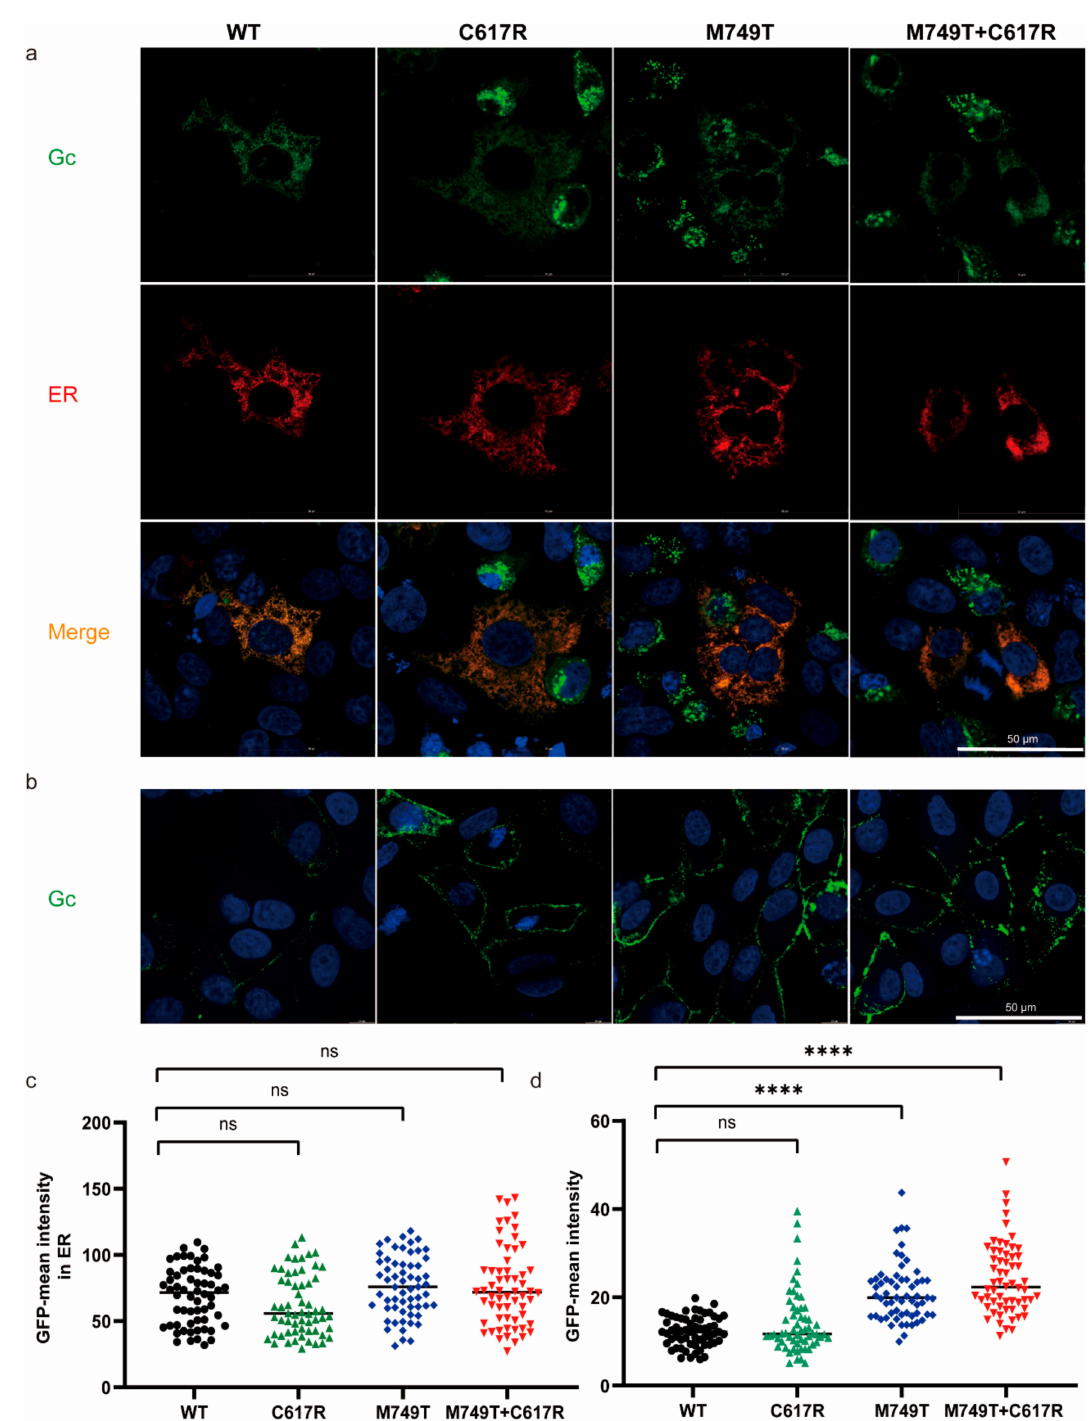
Figure 2. The effect of M749T and C617R mutations on the plasma membrane localization of Gc. ( a ) Vero cells were infected with rVSV-WT and variants 24 h after transfection with a plasmid encoding the ER reporter DsRed-KDEL (red) and stained with anti-Gc polyclonal antibodies (green) 24 h post-infection. ( b ) Live Vero cells were infected with rVSVs for 16 h and stained with anti-Gc polyclonal antibodies (green). ( c ) Quantification of the density of Gc in the whole cell from ( a ) ( n = 60). ( d ) Quantification of Gc in plasma membrane from ( b ) ( n = 60). Statistical significance was determined using an unpaired Student’s t -test. ns, p > 0.05; **** p < 0.0001. The above data are representative of three independent